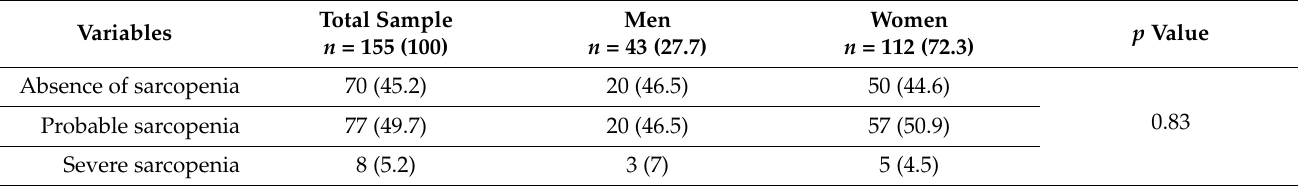
Table 3. Diagnosis of sarcopenia according to the EWGSOP2 criteria, by